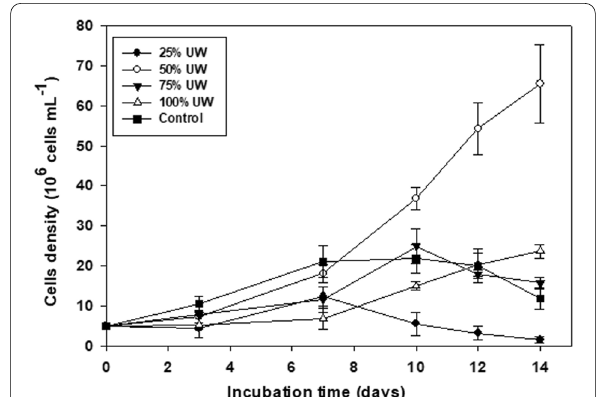
Fig. 1 Growth evolution of C. fusca (cells ml − 1 ) in the different treatments (control, 25% UW, 50% UW, 75% UW, and 100% UW), throughout the incubation period (14 days). Data are expressed as mean standard deviation (n 3) ± =